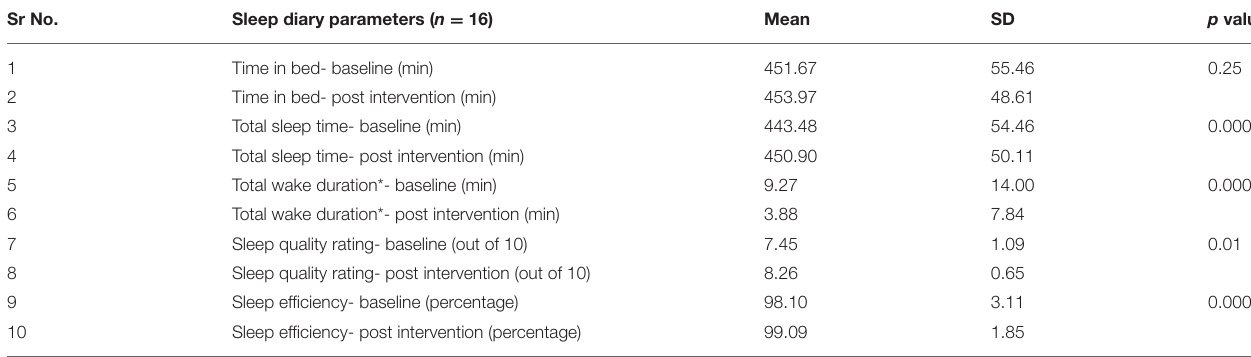
TABLE 1 | Sleep diary parameters of subjects. Sr